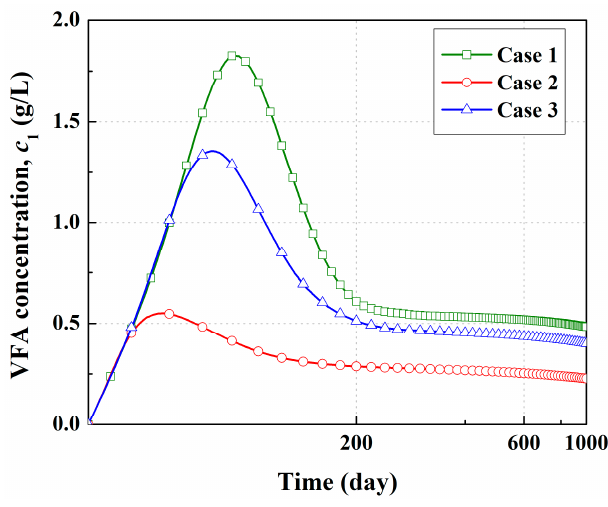
Figure 5. VFA concentration in leachate.